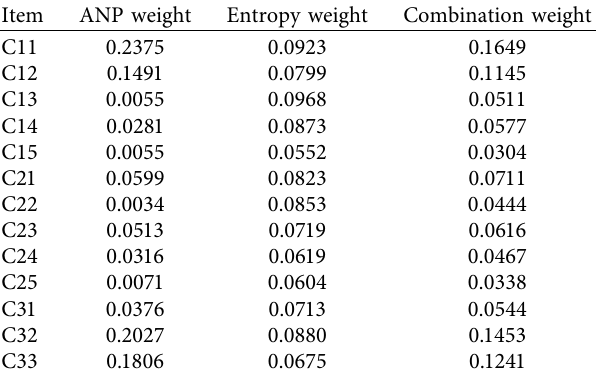
Table 2: Summary table of evaluation item weights.